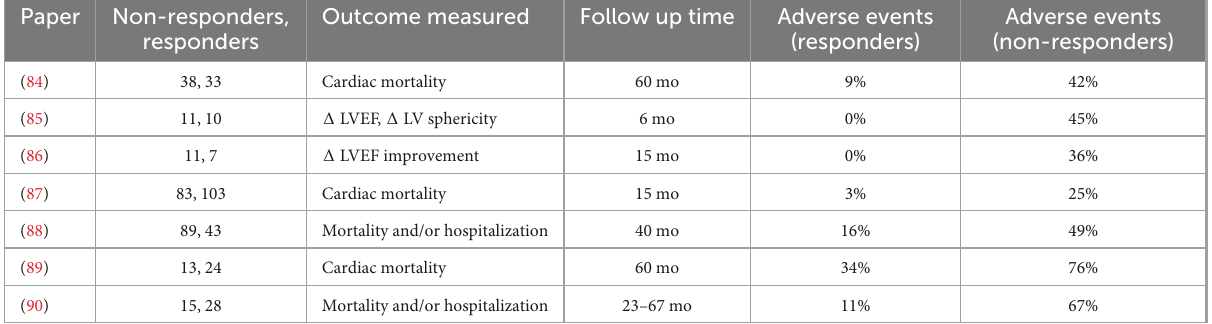
TABLE 3 Studies showing that reduced response to adrenergic stimulation is correlated with cardiac adverse outcome in patients with idiopathic DCM.